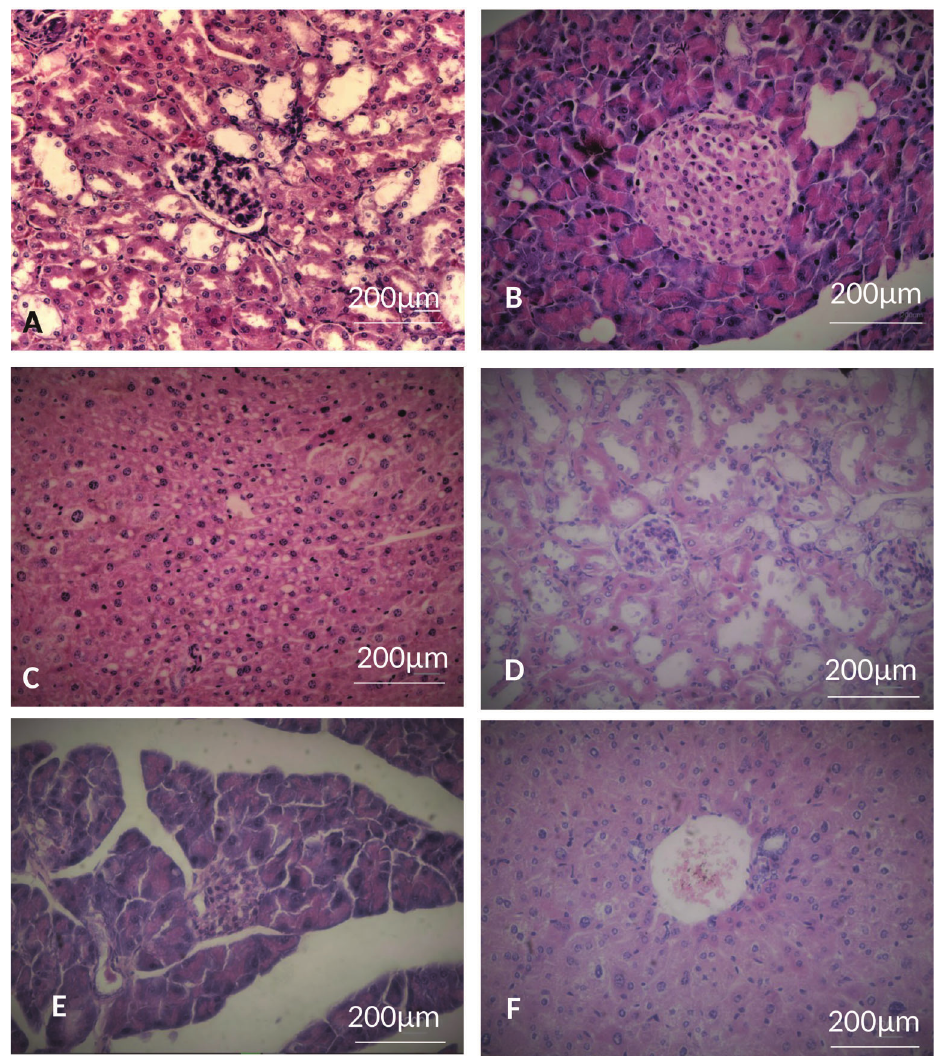
Figure 1. Histopathological observations of the kidney ( A ), pancreas ( B ) and liver ( C ) of mice treated with the aqueous extracts of faveleira and of the kidney ( D ), pancreas ( E ) and liver ( F ) treated with water. Hematoxylin-eosin staining. Table 2. Effect of the aqueous extracts of Cnidoscolus quercifolius on serologic levels of glucose in diabetic mice.